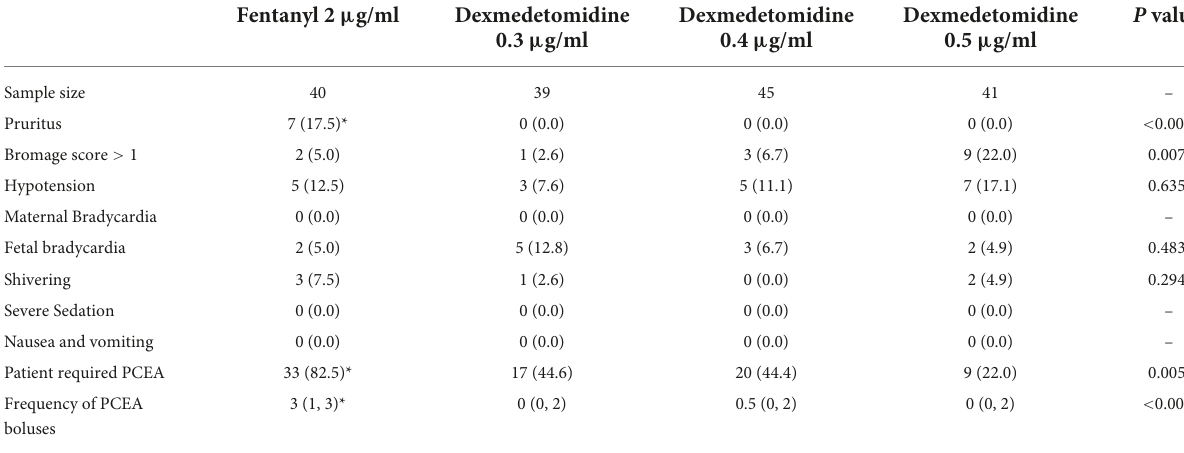
TABLE 2 Side effects and required patient-controlled epidural analgesia of epidural 2 µ g/ml fentanyl verse three different concentrations of